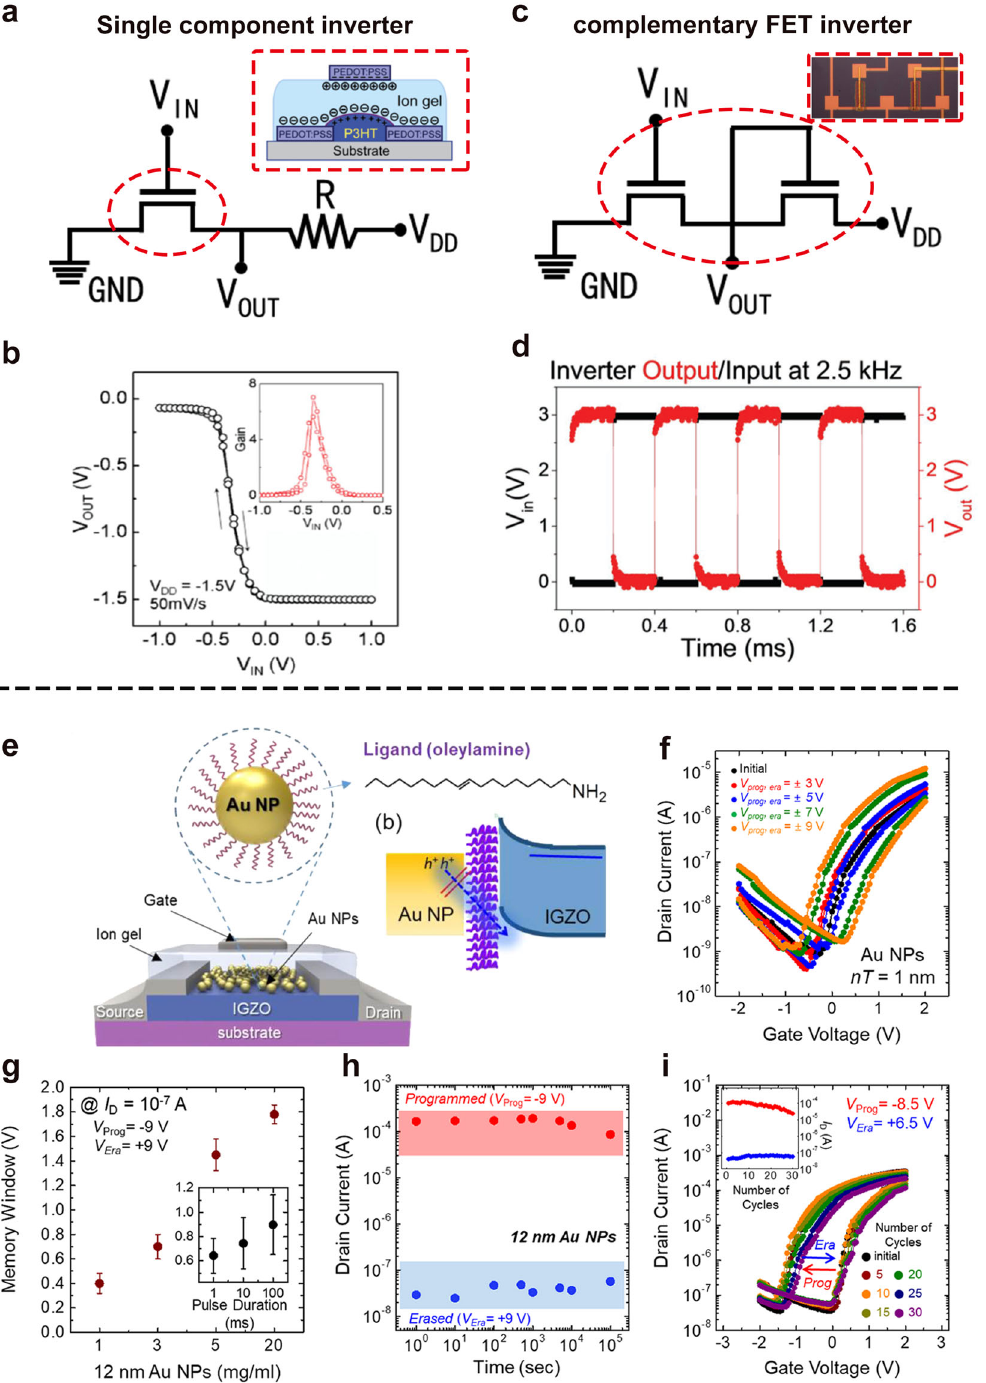
Fig. 10 Integrated circuit functions formed by ion-gel-gated transistor. a The circuit diagram of a Single-component inverter. Reproduced with permission 121 . Copyright 2010, Wiley-VCH. The inset is a scheme of an all-printed ion-gel-gated P3HT transistor with PEDOT: PSS electrodes. b Characteristics of a single-component inverter. c The circuit scheme of the complementary inverter. The upper inset shows the optical image of this complementary inverter. d The dynamic performance of the complementary inverter. e Schematic cross-section of the memory device with colloidal Au NPs with ligands. The chemical structure of the ligand molecule, oleylamine. f Transfer characteristics for an ionic-gel-gated IGZO NvTM containing Au NPs that were applied with different V prog and V era . g Summary of the voltage drift in the transfer characteristics of devices prepared from colloidal gold dispersions of different concentrations at ± 9 V program/erase voltages. h Retention characteristics of the programmed and erased signals for an ionic-gel-gated IGZO NvTM. i A series of transfer characteristic curves of ionic-gel gated IGZO NvTM with multiple application/erase operations. Reproduced with permission 126 . Copyright 2018, American Chemical